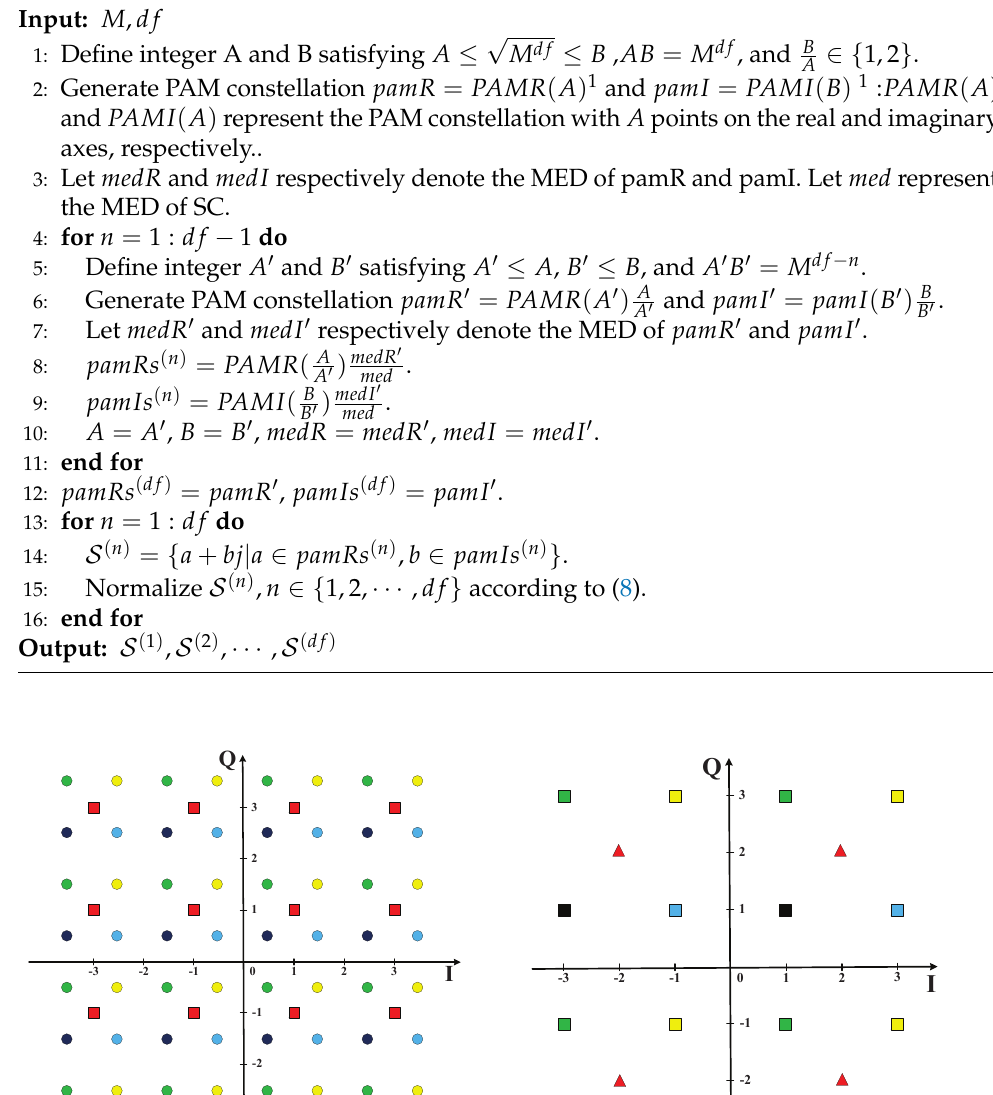
Algorithm 1 Decomposition of the superposed constellation